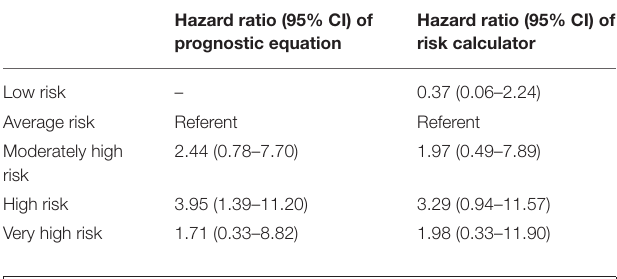
TABLE 3 | Hazard ratios for each risk group.